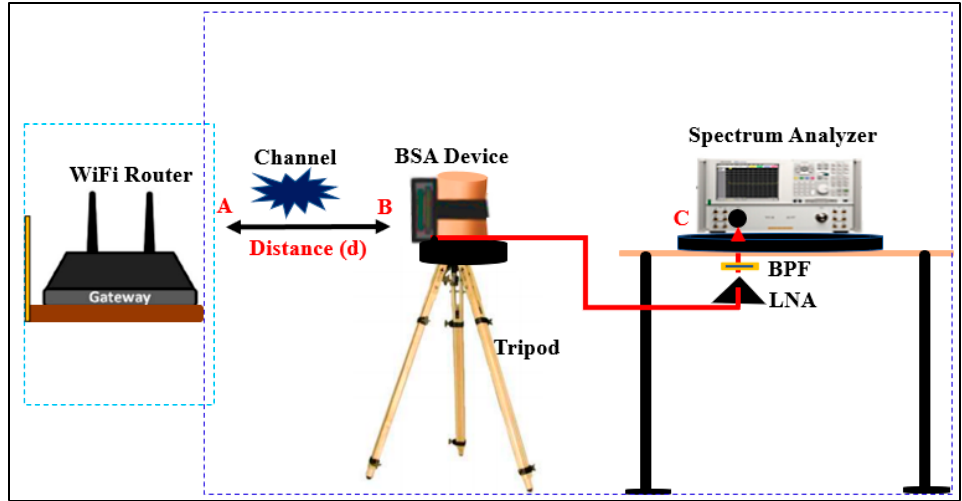
Figure 21. Measured S 11 of the BSA in wet situations (dry, after 1 h (1 Hr), 2 h (2 Hrs), and 3 h (3 Hrs)).